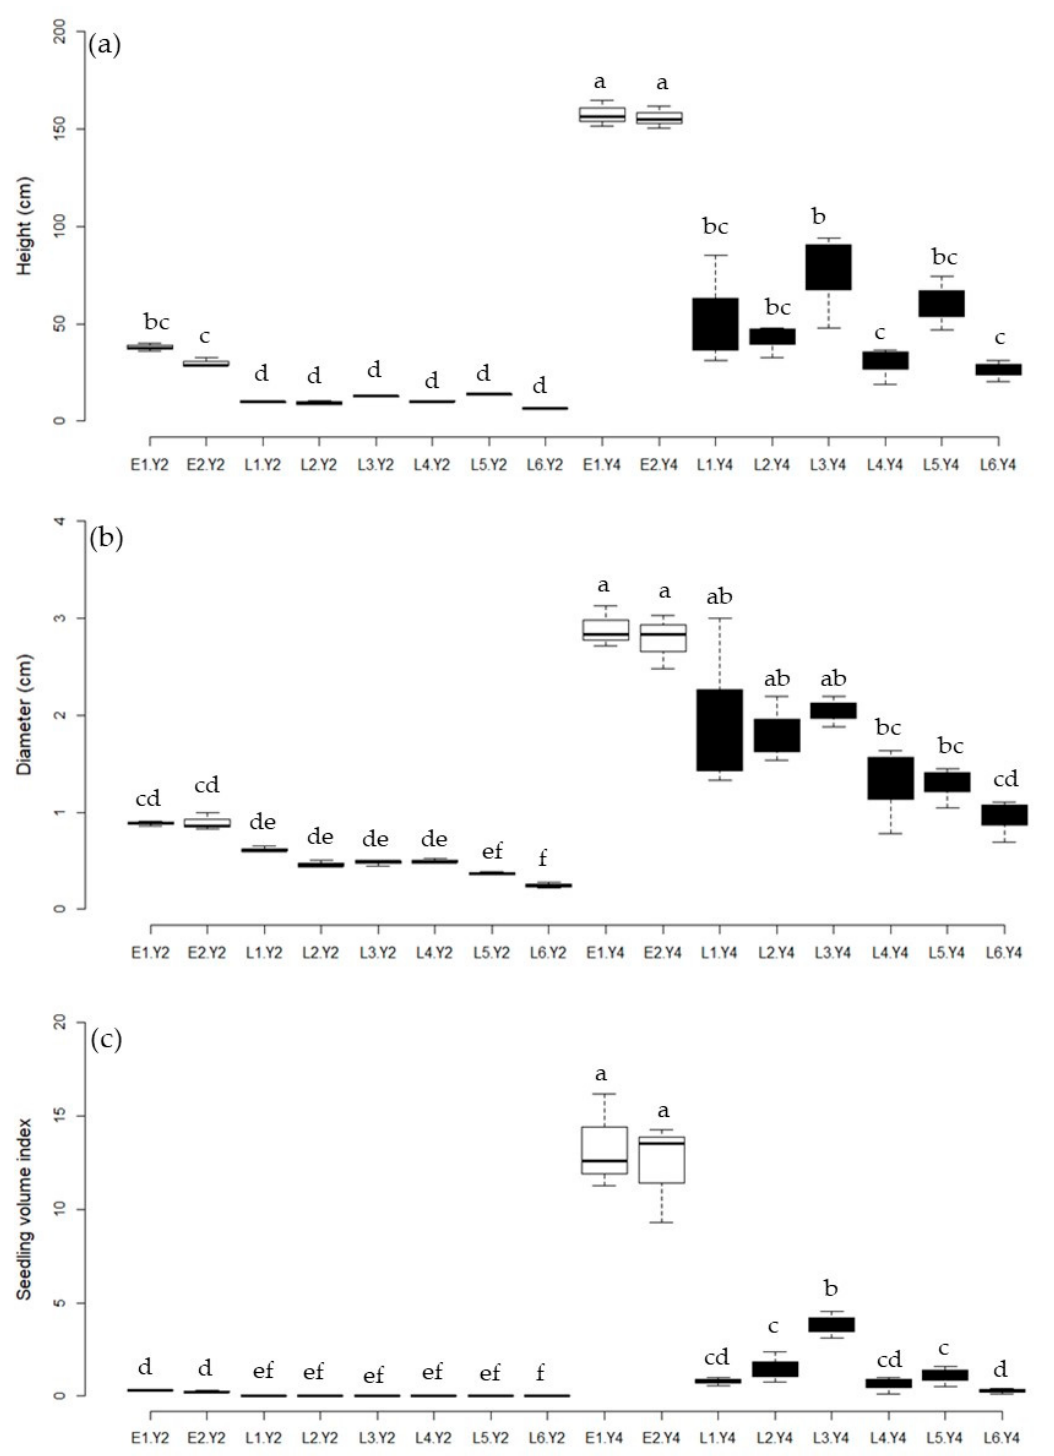
Figure 3. Seedling growth of 8 tree species of woodland. ( a ) Height (cm), ( b ) diameter of the stem measured at the root collar (RCD, 2 years) and at 10 cm above the soil surface (4 years) (cm) and ( c ) seedling volume index (cm 3 ). E and L: early and late successional species, respectively. Y2 and Y4: 2 and 4 years after planting, respectively. E1: C. collinum and E2: P. tinctorius (ES); L1: B. boehmii , L2: B. longifolia , L3: B. spiciformis , L4: B. wangermeana , L5: J. globiflora and L6: J. paniculata (LS). N = 3 replicates (subplot) and 3 seedlings per replicate and per species Box and whisker plots summarize the 25th, 50th (median line) and 75th percentiles defining the box, together with the 10th (lower whisker) and 90th (upper whisker) percentiles, for the responses for each species. Letters above the boxplots indicate mean differences with respect to age and species, according to post-hoc Tukey HSD tests ( p < 0.05).